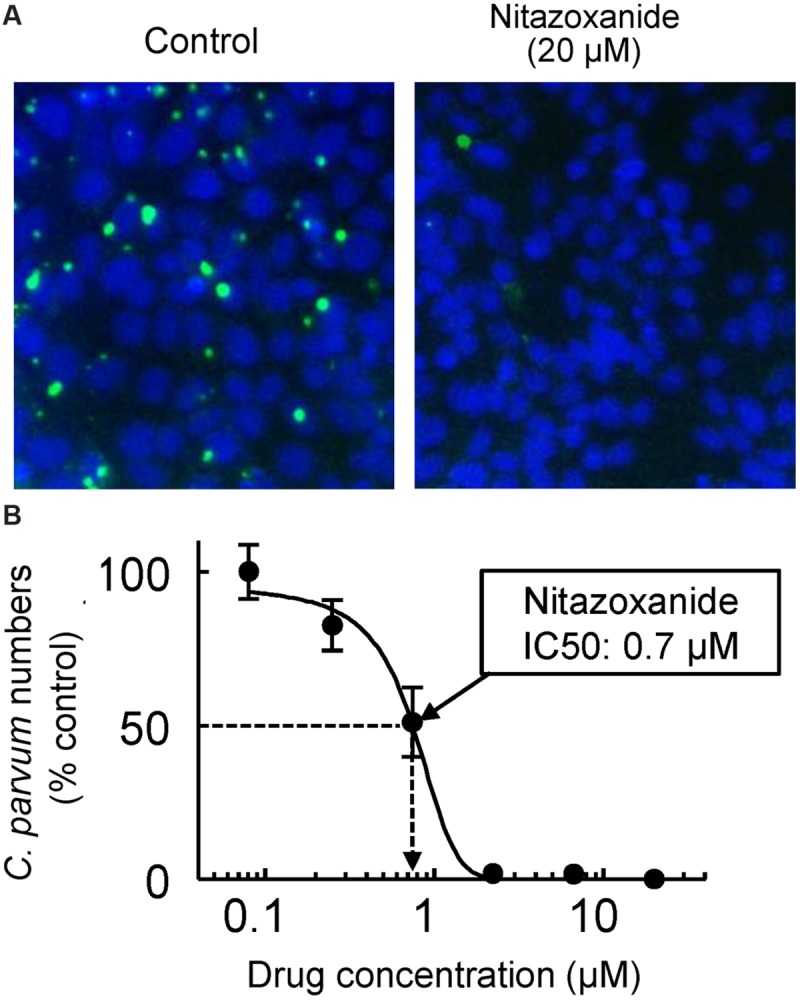
In vitro drug assay for Cryptosporidium. HCT-8 human intestinal epithelial cells were grown as monolayers in 96-well plates to 60–80% confluence. Cryptosporidium parvum oocysts, pretreated for 10 min at 37°C with 10 mM HCl and 10 min at 15°C with 200 μM sodium taurocholate to promote excystation, were added to the wells (105 oocysts/well). After a 4 h infection period, monolayers were washed, serial dilutions of nitazoxanide were added, and cultures were incubated for 48 h at 37°C in 5% CO2 and 95% air. Cells were fixed with 3% formaldehyde, permeabilized with Triton X-100, and stained with FITC-conjugated Vicia villosa lectin to detect C. parvum and counterstained with Hoechst 33342 to detect nuclei. A representative image of host cell nuclei (blue) and parasites (green) is shown in (A) for controls (left) and after exposure to 20 μM nitazoxanide (right). A concentration-response curve is shown in (B). Data are mean ± SD of triplicate wells, and are expressed relative to the parasite load in untreated controls. The half-maximal inhibitory concentration (IC50) for nitazoxanide was 0.7 μM.